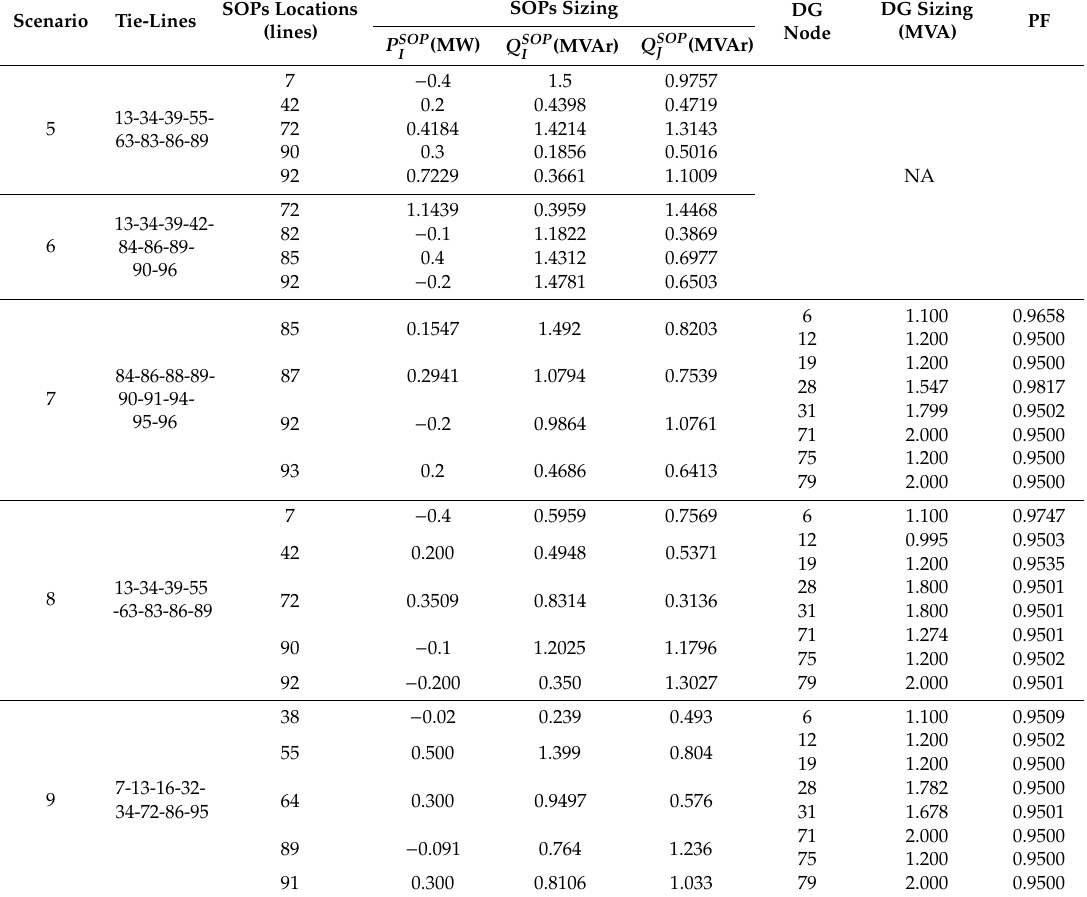
Table A3. Optimal system configuration, sizing and locations of SOPs and DGs for scenarios 5 to 9 without SOPs internal losses at normal loading level: 83-node distribution